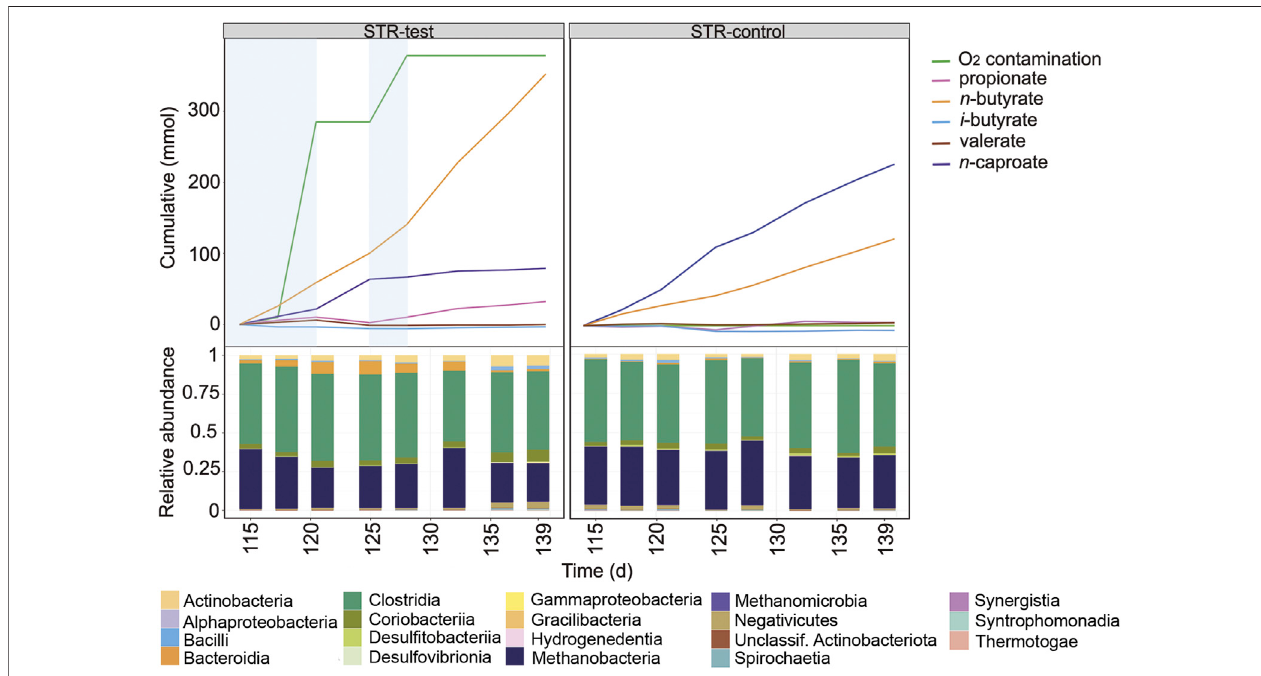
FIGURE 3 | Pro fi les of the cumulated amounts of carboxylates and O 2 , as well as community composition at class level between days 115 and 139 for STR-test and STR-control. Blue shading indicates the O 2 contamination